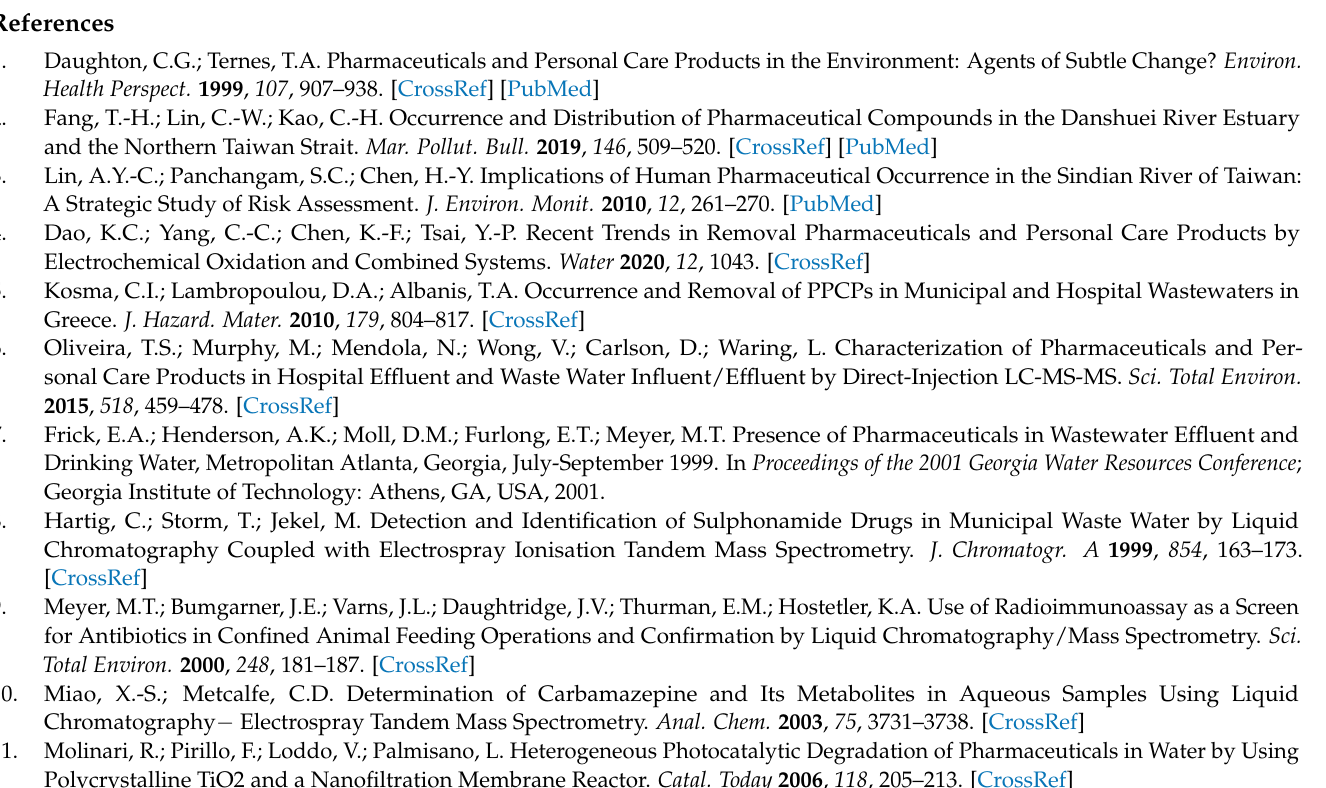
practice, Figure S2: SEM photo of section part of flat-sheet ceramic membrane, Figure S3: Comparison of predicted and actual values of: (a) CBZ, (b) COD, (c) ammonia, and (d) phosphorus removal efficiency, Figure S4: HPLC–DAD chromatogram of CBZ standard containing 100 µ g/mL at 210 nm wavelength, Table S1: Physico-chemical and pharmacological properties of CBZ, Table S2: Experimen- tal values of trans-membrane pressure (TMP), Table S3: Average influent and effluent concentrations ( ± SD) of CBZ, COD, ammonia, and phosphorus through